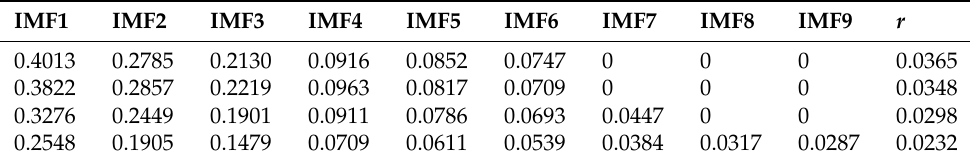
Figure 7. The whitening EMD algorithm component graph of the impact signals at point a, b, c, d. Table 4. Correlation table for each order IMF of the whitening EMD